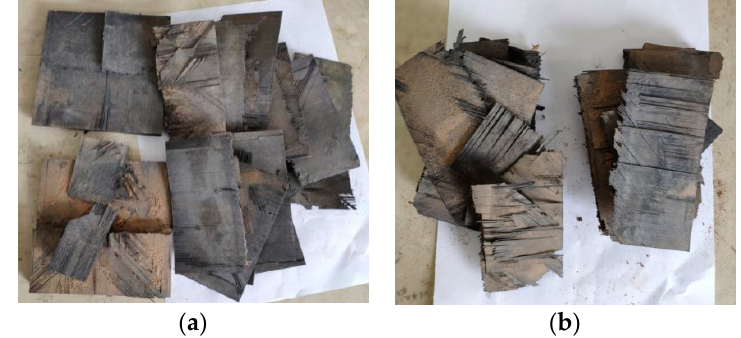
Figure 5. Results of lateral opening charge blasting test. ( a ) 15 mm; ( b ) 25 mm.